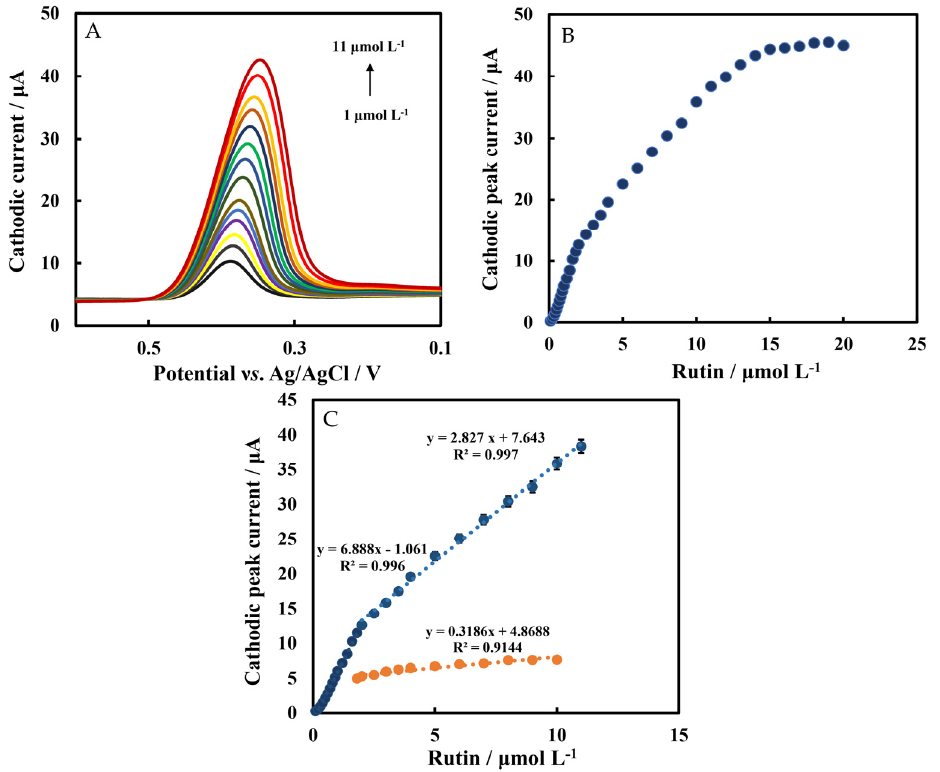
Figure 8. ( A ) LSVs of Chi/HFs − Lac/MWCNTs − CTAB/GCE at different concentrations of rutin. ( B ) Plot of cathodic peak current versus rutin concentrations. ( C ) Cathodic peak current versus rutin concentrations of Chi/HFs − Lac/MWCNTs − CTAB/GCE (blue line) and Chi/HFs/MWCNTs − CTAB/GCE (orange line). The experiments were carried out in 50 mmol L − 1 pH 4 phosphate-buffered solution at a scan rate of 0.1 V s − 1 . Table 1. Comparison of the performances of electrochemical sensors for determination of Rutin. Liner Working Electrode